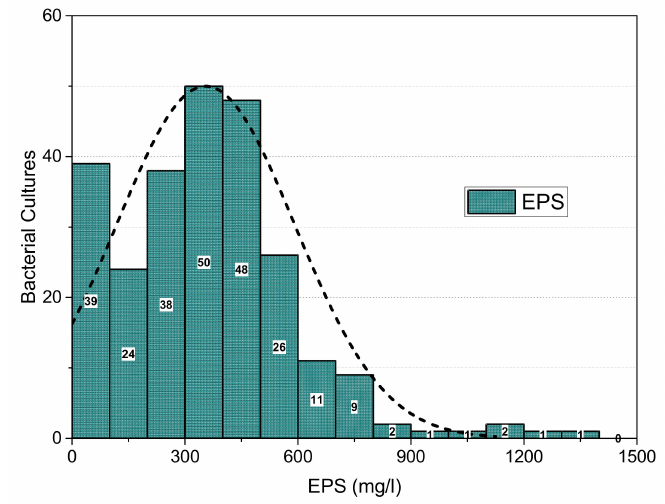
Figure 1. EPS-producing capability of isolated bacteria isolated from rice sodic